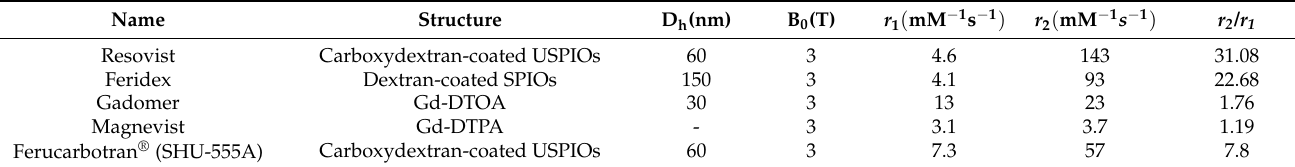
Table 4. Main characteristics of some commercial MRI contrast agents